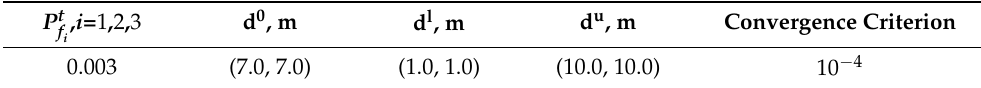
Table 10. Target failure probability and parameters for the reliability analysis and optimization.